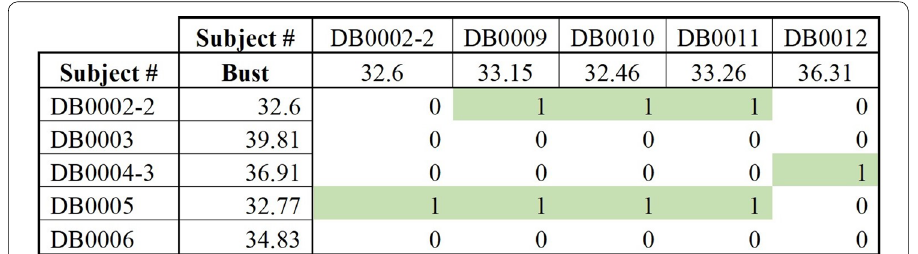
Fig. 1 Sample of the bust matrix showing layout and color coding